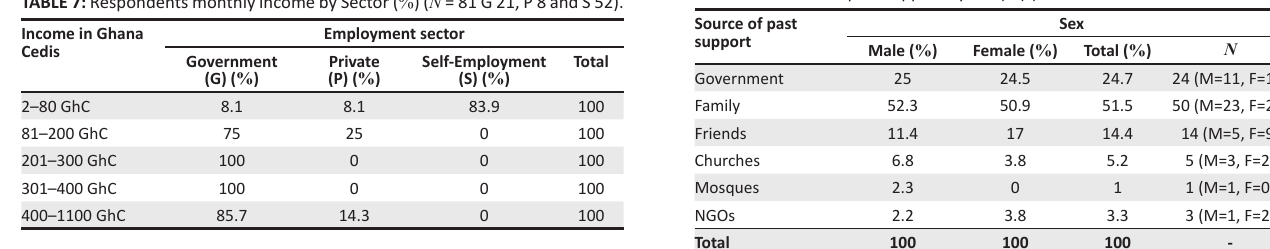
TABLE 9: Sources of past support by sex ( % ) ( N = 97 Females 53 and Males 44)